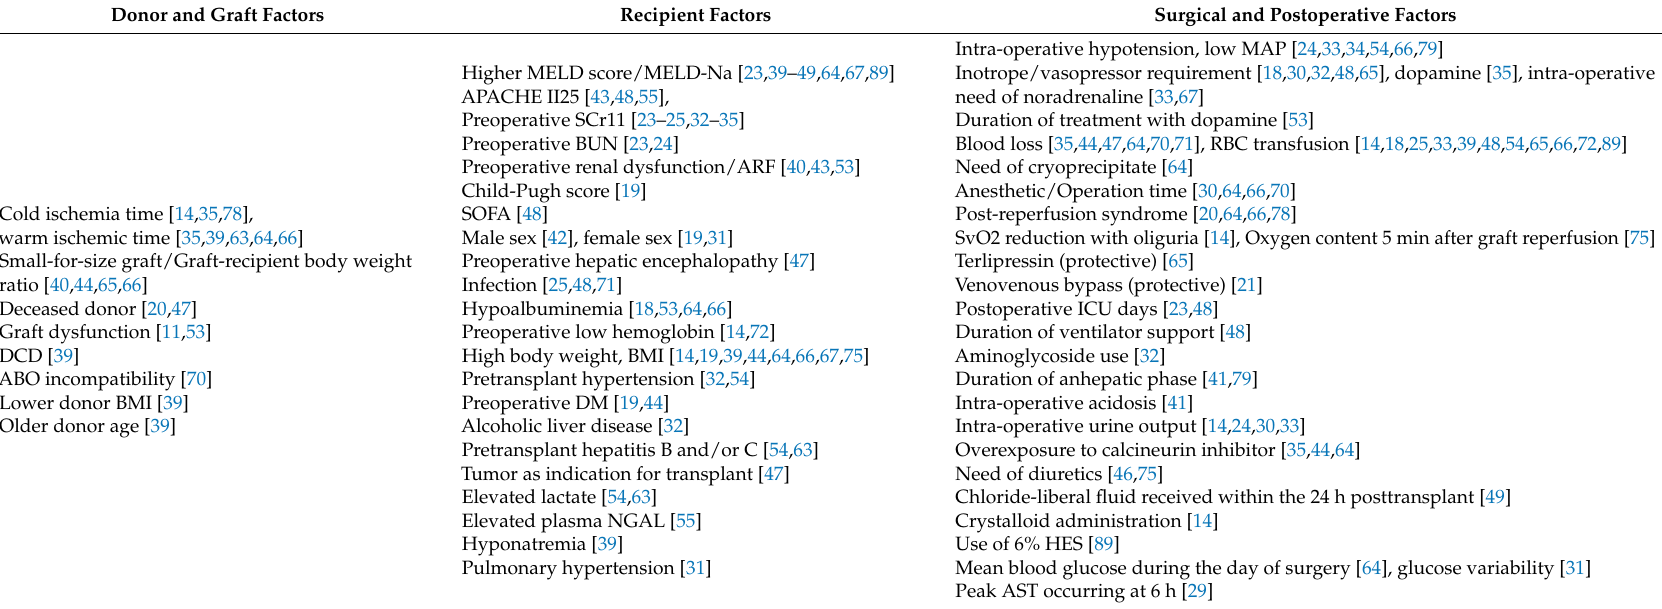
Table 2. Reported Potential Predictors/Associated-Risk Factors of Post-LTx